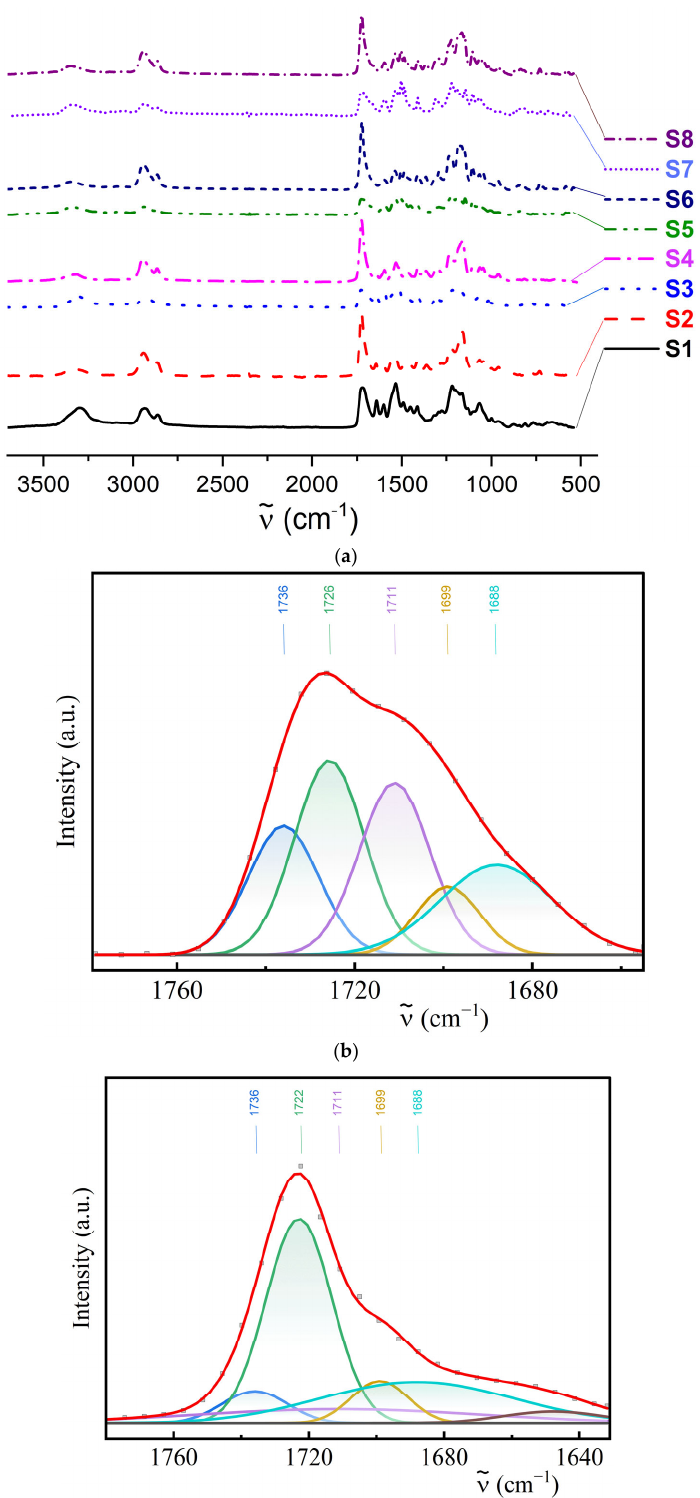
Figure 3. IR spectra for S1–S8 compositions of PUU ( a ) as the function of absorbance on wavenumbers. The deconvolution of the IR spectrum for S3 ( b ) and S8 ( c ) according to the methodology presented in [43]. The red line is the approximation using the six peaks of the Gaussian function [44].(Figure S4 in Electronic Supplementary Materials—ESM)